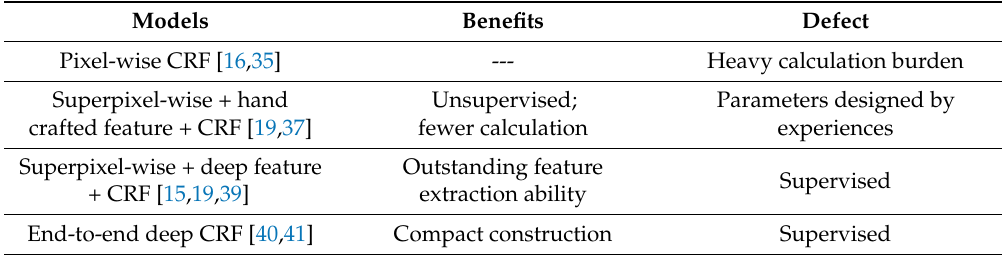
Table 1. Compared recently CRF-based segmentation in terms of pros and cons.